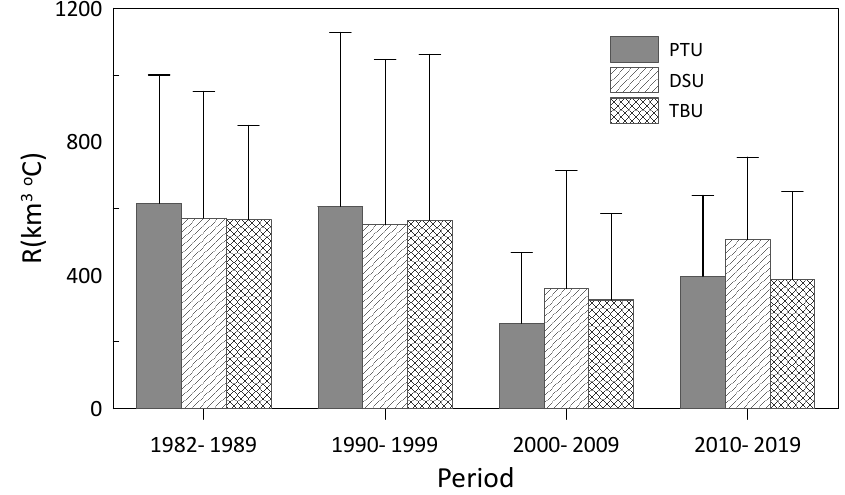
Figure 4. Variation in upwelling intensity (R) over four different periods. Table 1. Statistical results in the change of R and Q cross before 2000 and after 2000.